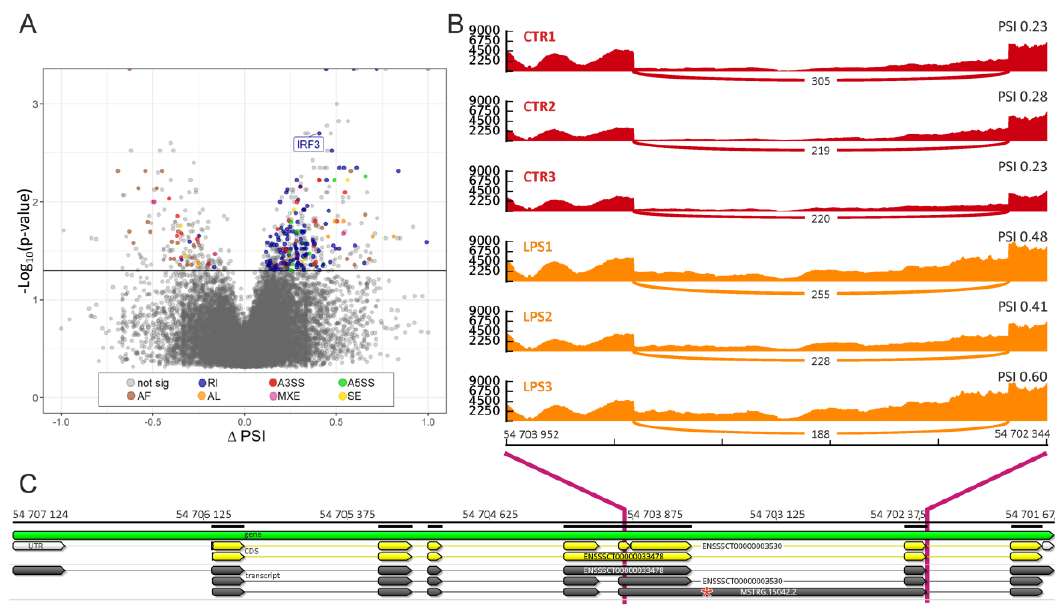
Figure 5. The distribution of differentially alternative splicing (DAS) events. ( A ) Volcano plot shows the difference in the percent splicing inclusion (ΔPSI) values in each alternative splicing (AS) event ( X axis) and the Y axis depicts the logarithmic adjusted p -values. The horizontal line describes adjusted p-values cut-off (0.05). Colors of the dots indicate specific types of DAS: skipping exon (SE—yellow), alternative 5′ splice site (A5SS—green), alternative 3′ splice site (A3SS—red), mutually exclusive exons (MXE—pink), retained intron (RI—blue), alternative first (AF—brown), last exon (AL—orange), and not a significant event (grey). ( B ) Quantitative visualization (Sashimi plot) of the intron 5 (I5) retention within the IRF3 gene. Each track visualizes the splicing event (RI of I5) within the biological replicates for the control (red) and LPS-treated (orange) samples. Count values on curved lines describe the coverage within the splice junction. The left scale presents the coverage depth of IRF3 in the range of the AS region. PSI values are presented on the right side for each track. ( C ) Genomic coordinates of the DAS event within IRF3 located on chromosome 6. Yellow tracks show 2 known ENSEMBL coding regions (CDS) of the IRF3 gene. Grey tracks show 2 known and 1 novel transcripts of IRF3 identified in our study. Red star shows the position of the stop codon in the alternative spliced IRF3 mRNA (MSTRG.15042.2) after intron retention.